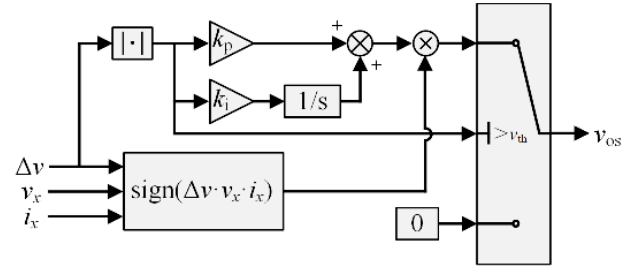
Figure 9. The calculation process of v os . Table 5. Compensation voltage injection rules.